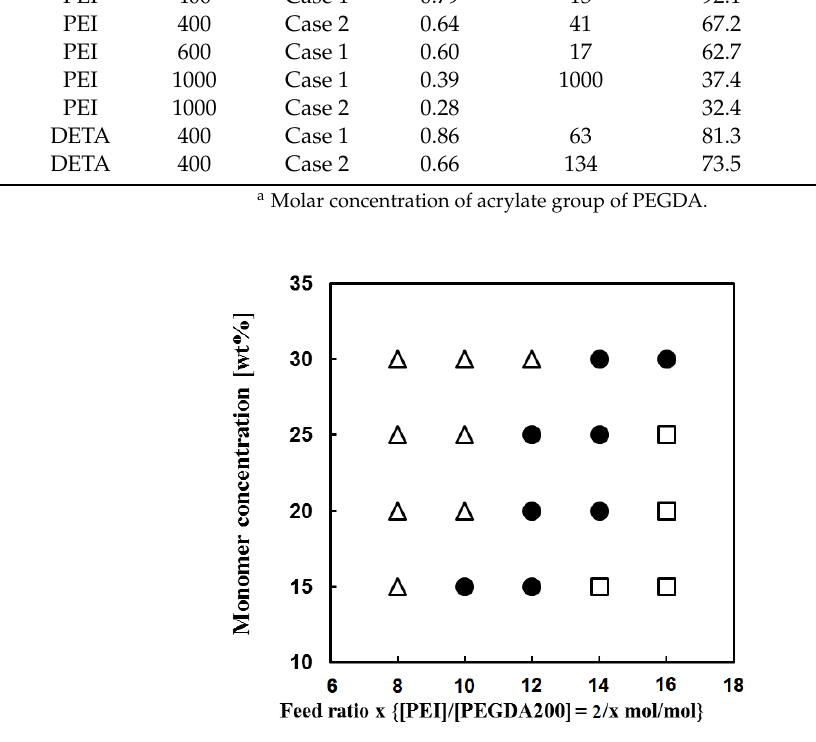
Figure 5. Production diagram of PEI-PEGDA200 reaction system in EtOH, reaction temperature: 20 °C, Δ gel, ● porous polymer, □ precipitate.